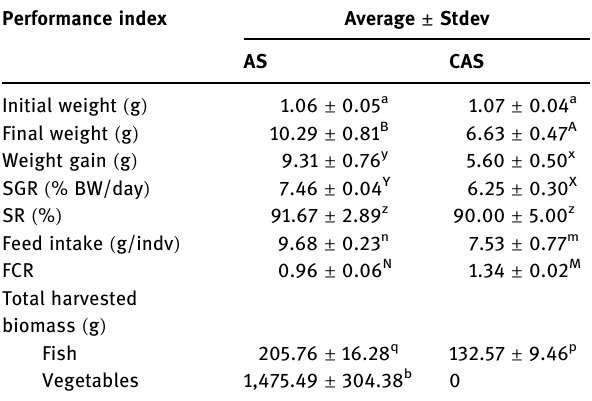
Performance index Average ± Stdev